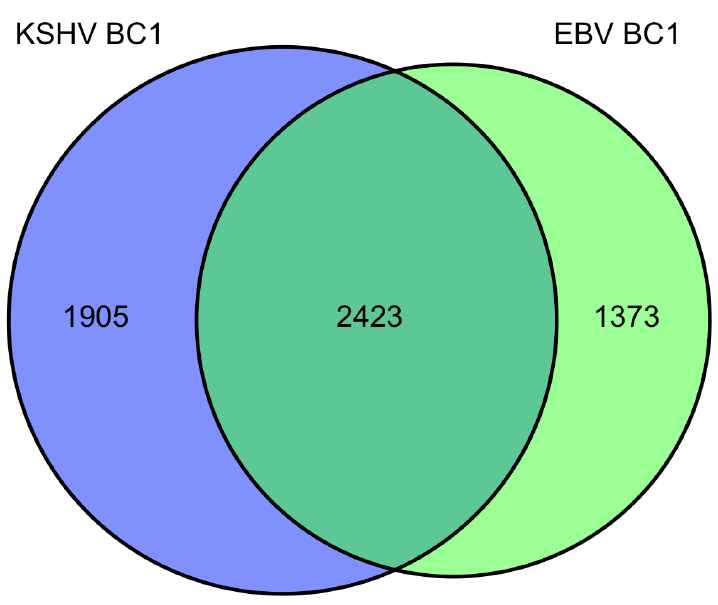
Table 3. BC1 overlapping miRNA target